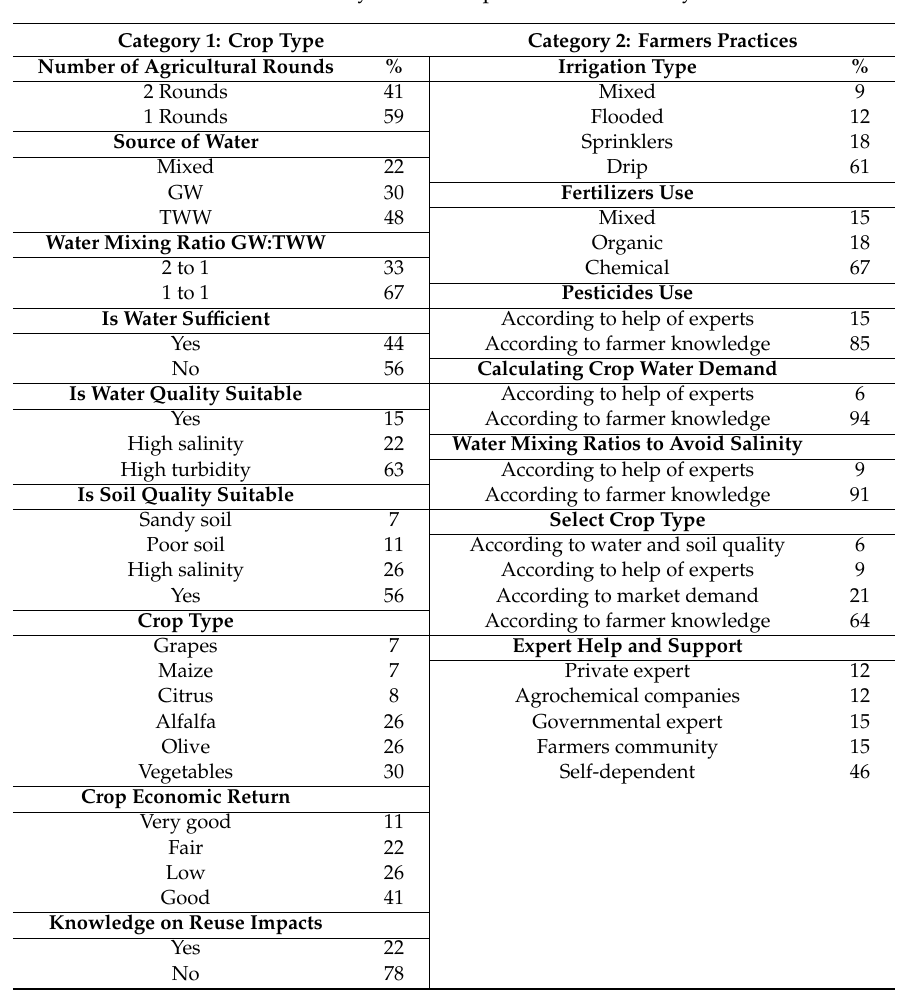
Table 1. Field survey of farmers practices in the study